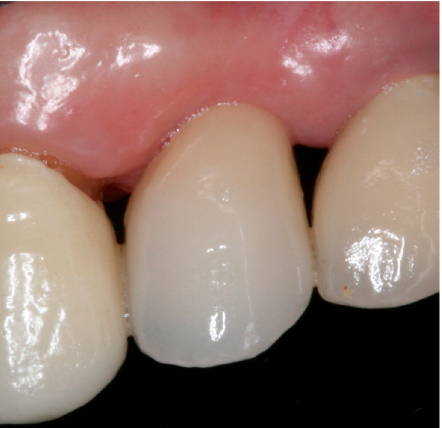
Figure 9. Intra-oral buccal view of #24 with ceramic screw-retained crown after 14 months in function.